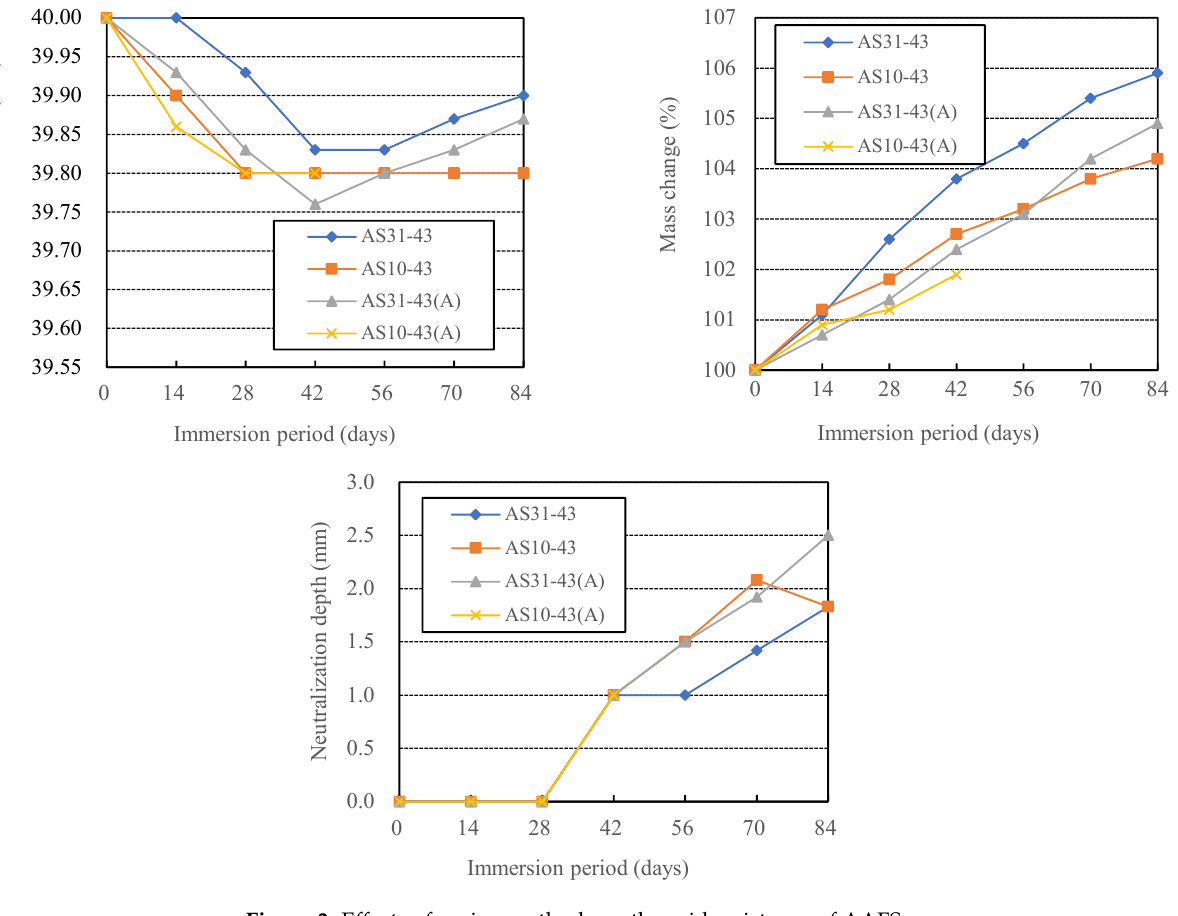
Figure 3. Effects of curing methods on the acid resistance of AAFS. The corrosion mechanism of hardened AAFS paste in sulfuric acid (pH (cid:59) 1.0) consists charge-compensating cations (Na + , Ca 2+ ) of C-N-A-S-H gels and the H + or H 3 O + ions